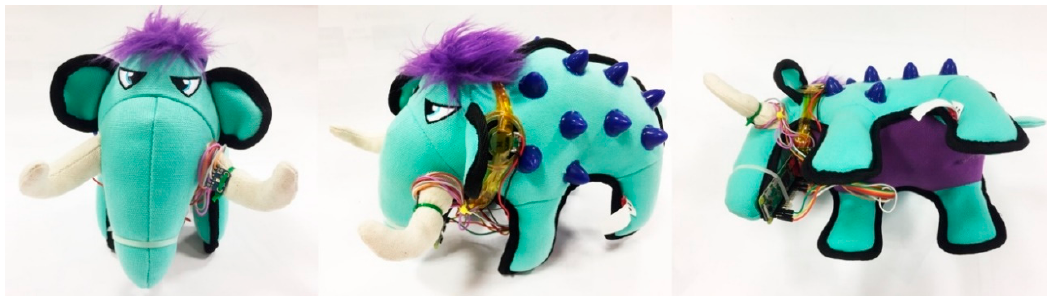
Figure 2. Non ‐ intrusive integration of the hardware with MAmIoTie. Figure 2. Non-intrusive integration of the hardware with